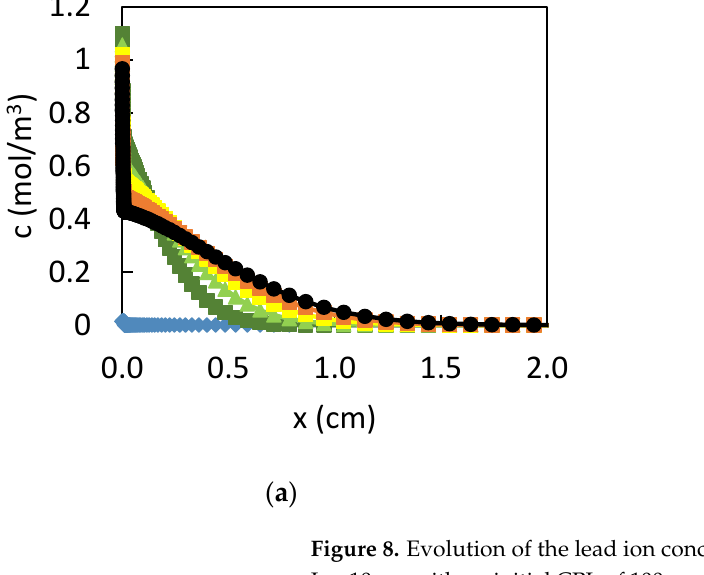
( b ) Figure 9. Evolution of the chloride ion concentration in an electrolyte of 1000 mol/m 3 HCl and of size L = 10 cm with an initial CPL of 100 µm and a fixed porosity of 0.9 ( a ) the first 2 cm and ( b ) the first 200 µm of the electrolyte are presented for different times t = 0 s (light blue), 3600 s (dark green) 7200 s (green), 10,800 s (yellow), 14,400 s (orange), and 18,000 s (black).